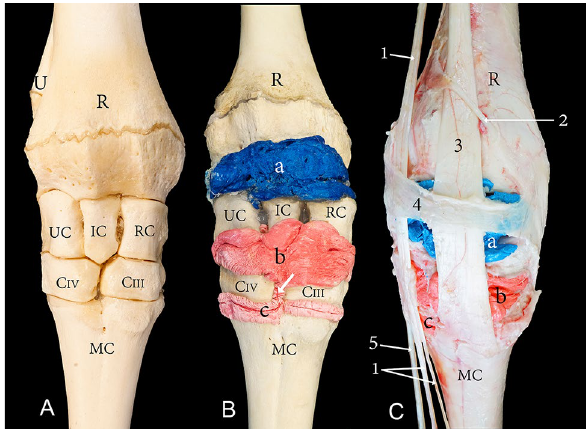
Figure 1. Dorsal view of the right carpus showing ( A ) bones, ( B ) casting, and ( C ) dissection. R, the distal end of the radius; U, the distal end of the ulna; RC, radiocarpal bone; IC, intermediate carpal bone; UC, ulna carpal bone; CIII, carpal bone III; CIV, carpal bone IV; MC, metacarpal bone; a, radiocarpal joint cavity; b, intercarpal joint cavity; c, carpometacarpal joint cavity; 1, common digital extensor tendon; 2, abductor pollicis (digit 1) longus; 3, extensor carpi radialis tendon; 4, extensor retinaculum; 5, lateral digital extensor tendon. The white arrow indicates the communication between the intercarpal and carpometacarpal joint